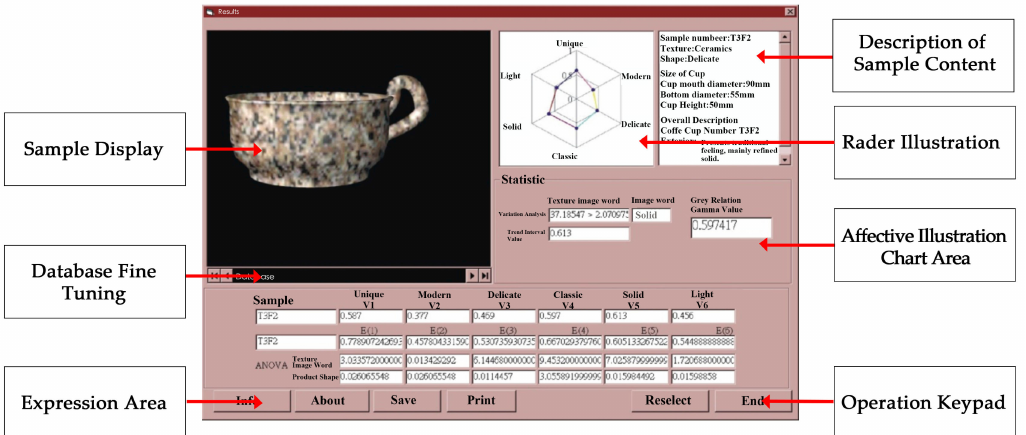
Figure 15. The Illustration Chart of Detailed Interface of Master